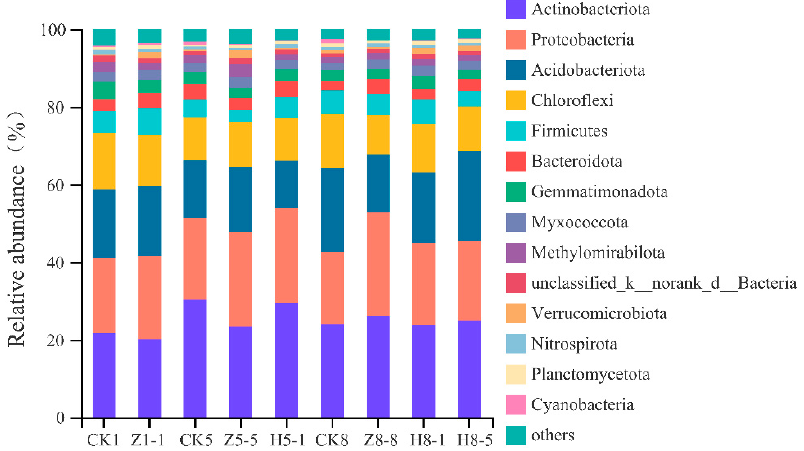
Figure 7. Community composition of bacteria at the phylum level in soil in different years of growing and replanting. Note: The nomenclature of each sample is the same as that in Table 2.